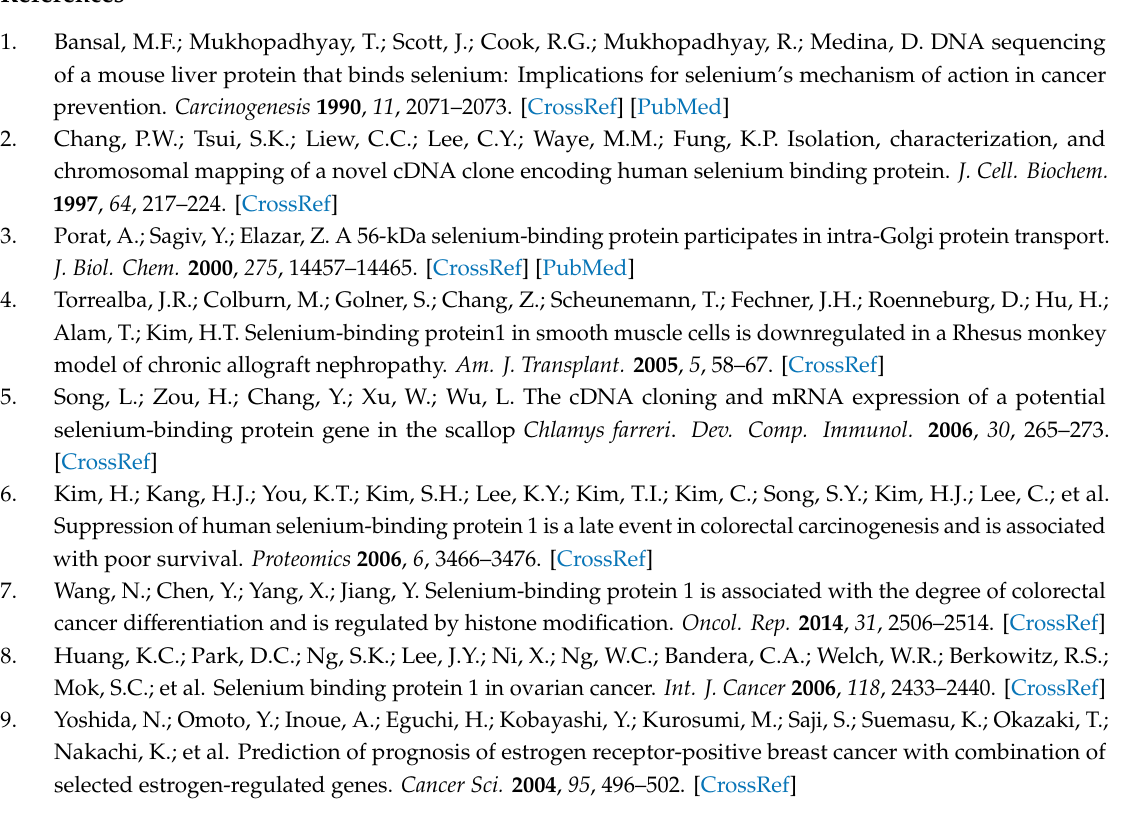
Figure S1: Luciferase reporter assay for inhibition of human and mouse Selenbp1 promoter by HBx., Table S1: Genes downregulated in Chang X31 cells, cDNA microarray, Table S2: Relationship between SELENBP1 expression and clinicopathological